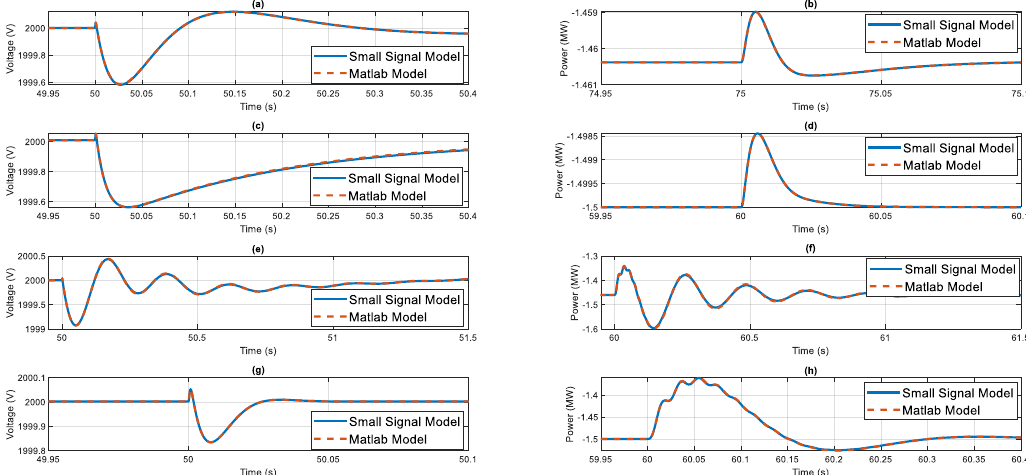
Figure 10. Validation of the drivetrain small-signal models: ( a ) Gen q-axis current step (1 A) to network